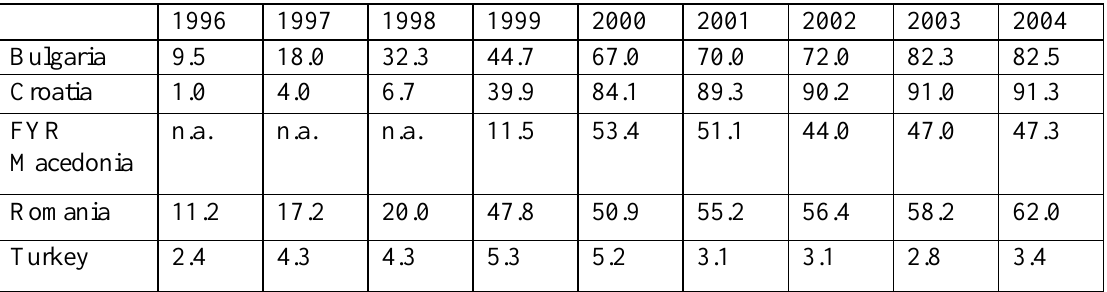
Table 4a. Market Share of Foreign Owned Banks (compared to the other Accession Countries) (Total Assets, in %)